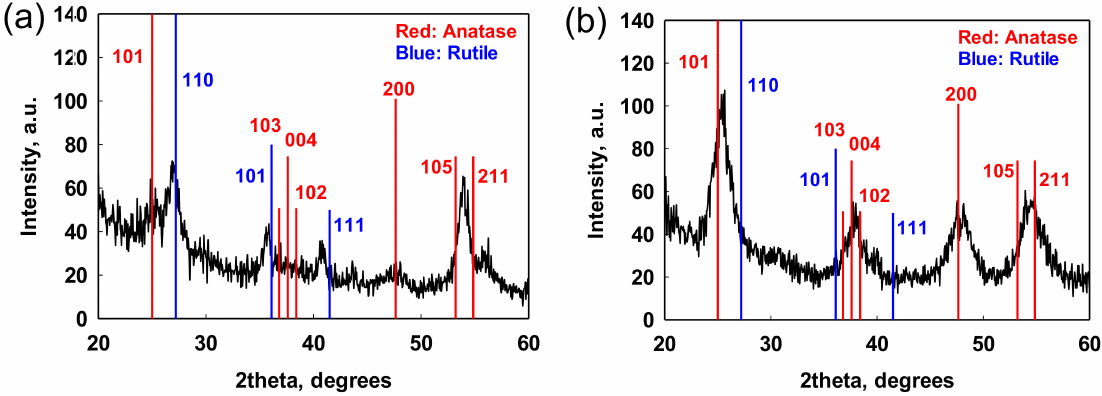
Figure 10. Data from the X-ray analysis of the dried particles, synthesized in emulsions which were obtained by Ultra Turrax stirring at ( a ) 20,500 rpm for 20 min and ( b ) 8000 rpm for 15 min. The initial emulsions were obtained by stirring at 20,500 rpm for 5 min. 1 wt % Span 80 in hexadecane was used as oily phase in both